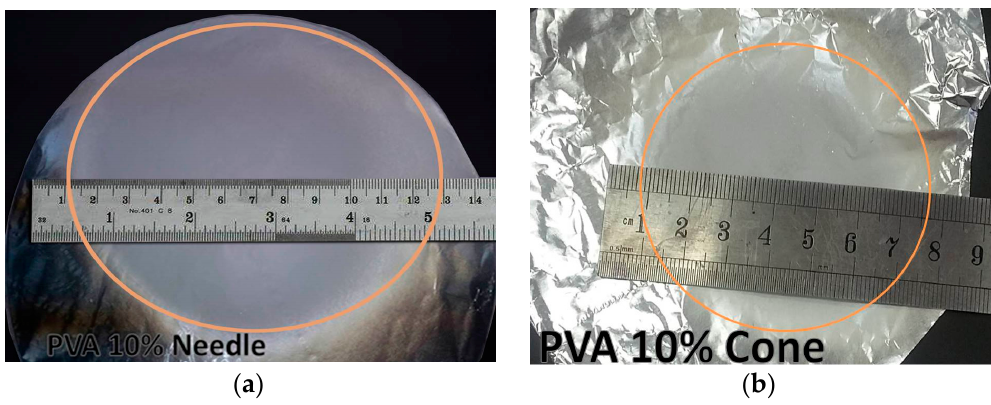
Figure 9. Deposition area of ( a ) Needle electrode ( b ) Cone electrode at same electrospinning process conditions (Material: PVA 10 wt %, Processing conditions: z = 15 cm, voltage = 25 kV, flow rate= 1 mL/h, Deposition time = 30 min).